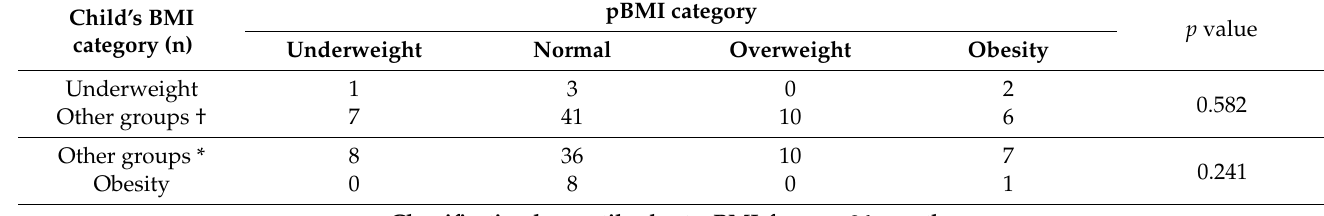
Classification by centile charts: BMI-for-age, 24